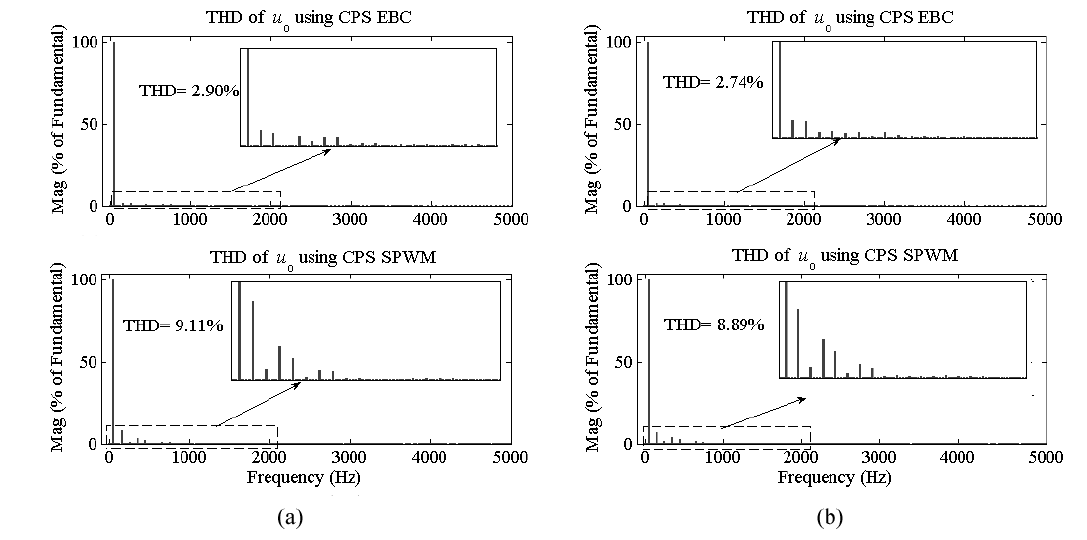
Figure 15. The comparison of the THD of the five-level experimental prototype under the case of DC voltages with fluctuations. ( a ) DC voltage u 1 contains a ripple with a frequency of 100 Hz and an amplitude of 16 V; and ( b ) DC voltage of each cascaded unit contains a frequency of 100 Hz and an amplitude of 8